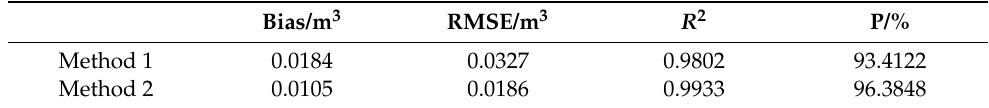
Table 13. Volume estimation